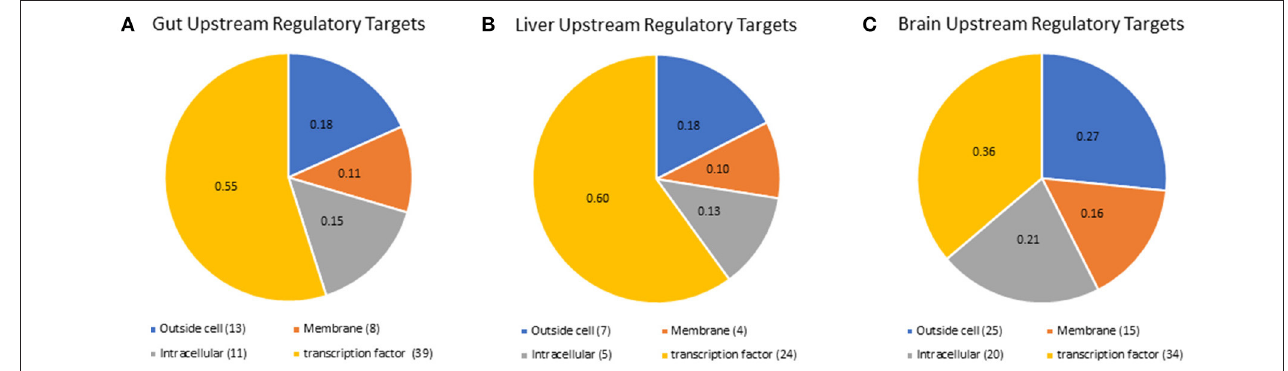
FIGURE 4 | Pathway studio representation of expression targets identified for (A) gut, (B) , liver, and (C) brain. All of the expression targets identified in any tissue were mapped by pathway studio to their cellular location by the GO categories. The ID’s for the expression targets are found in Supplementary Table 6